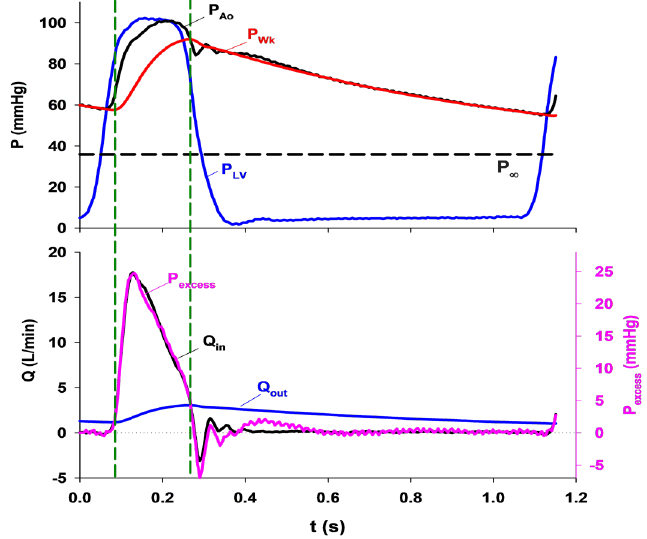
, black), left ventricular pressure ( P , blue), calculated Windkessel LV , black dashed line). Lower panel: excess pressure ( P , pink) calculated ∞ excess Ao , black) plotted against time with the scales adjusted so that their peak values in equals outflow ( Q , blue) and, therefore, P does not change in out Wk